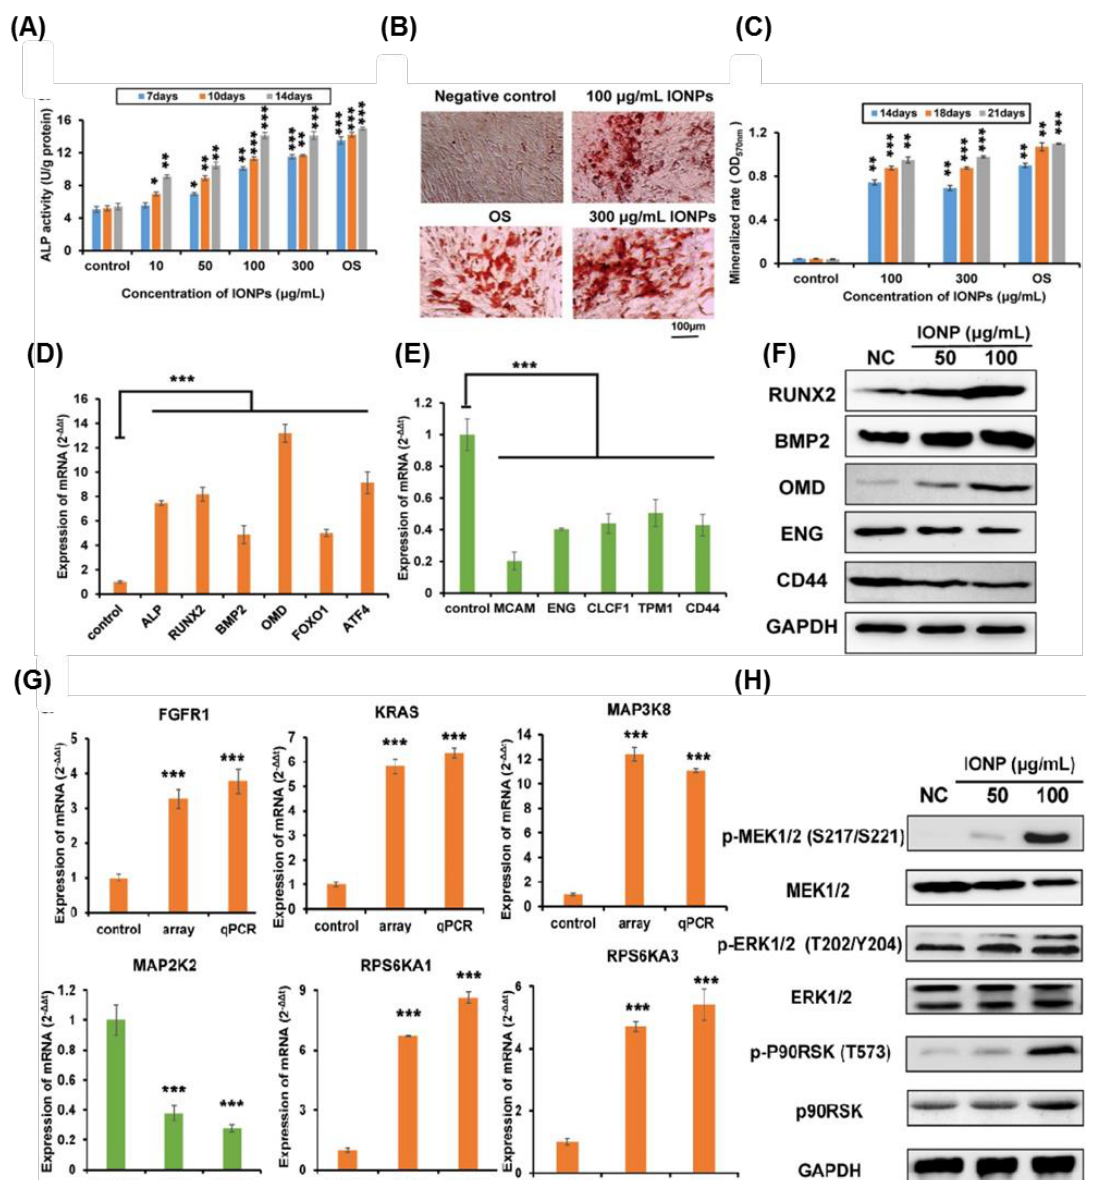
Figure 4. IONPs promoted the osteogenic differentiation of hBM-MSCs. ( A ) IONP-exposed hBM-MSCs showed high ALP activity in a dose-dependent manner (* p < 0.05; ** p < 0.01; *** p < 0.001). Scale bar: 100 µ m. ( B ) Calcium mineralization indicated by alizarin red S staining. ( C ) Quantification of alizarin red S staining (** p < 0.01; *** p < 0.001). ( D ) The quantitative real-time PCR data showed the upregulation of the osteogenic differentiation-specific genes when exposed for one week to IONPs at 100 µ g/mL (*** p < 0.001). ( E ) The downregulation of the MSC-specific markers after exposure to IONPs at 100 µ g/mL for one week (*** p < 0.001). ( F ) Upregulation of the protein level of the osteogenesis-associated proteins in IONP-treated hBM-MSCs. ( G ) The quantitative real-time PCR analysis results displayed the significant increase in the expression levels of mRNAs of the classical MAPK-related genes upon exposure to IONPs (100 µ g/mL) for one week (*** p < 0.001). ( H ) Western blot analysis showed the phosphorylation of MAPK-associated proteins. This figure is reproduced from [154] with Elsevier’s permission.